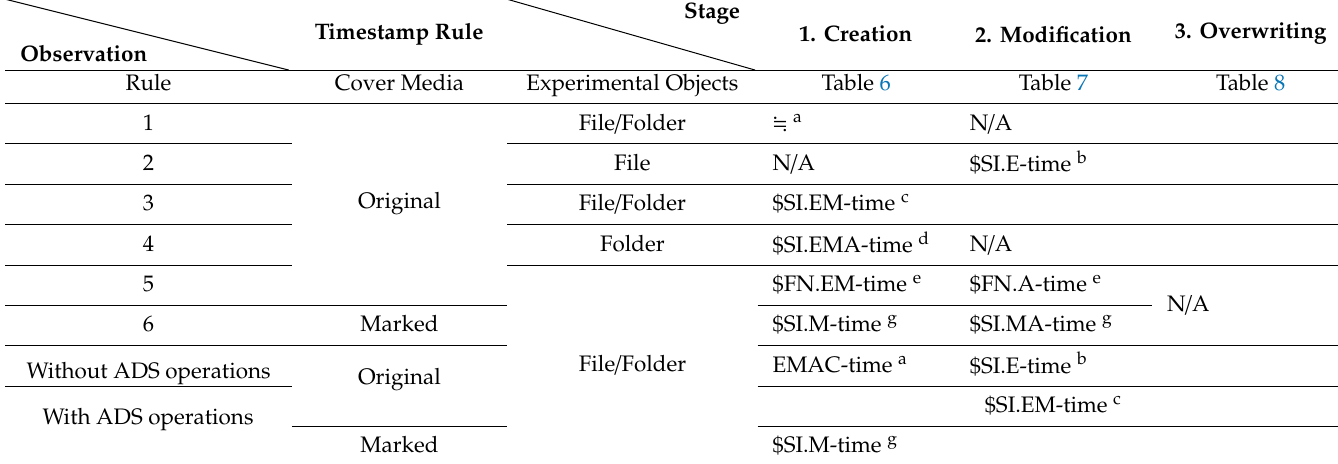
Table 11. Relational reconstruction among timestamp rules, experimental objects, and their